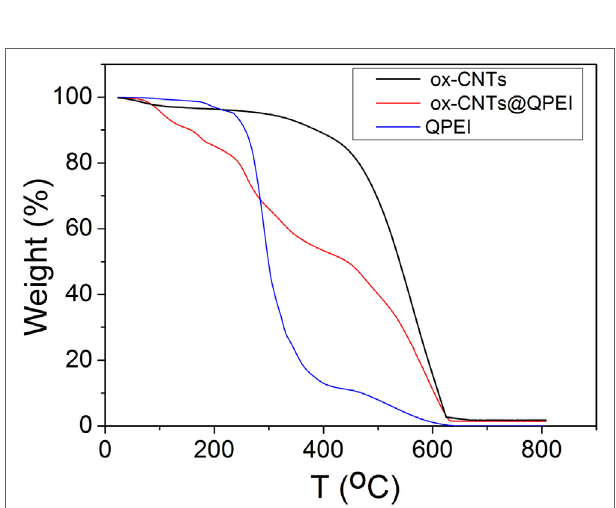
FigUre 2 | Thermogravimetric profiles of oxidised­carbon nanotubes (ox­CNTs) (black), quaternized hyperbranched polyethyleneimine (QPEI) (blue), and ox­CNTs@QPEI (red) measured in air.